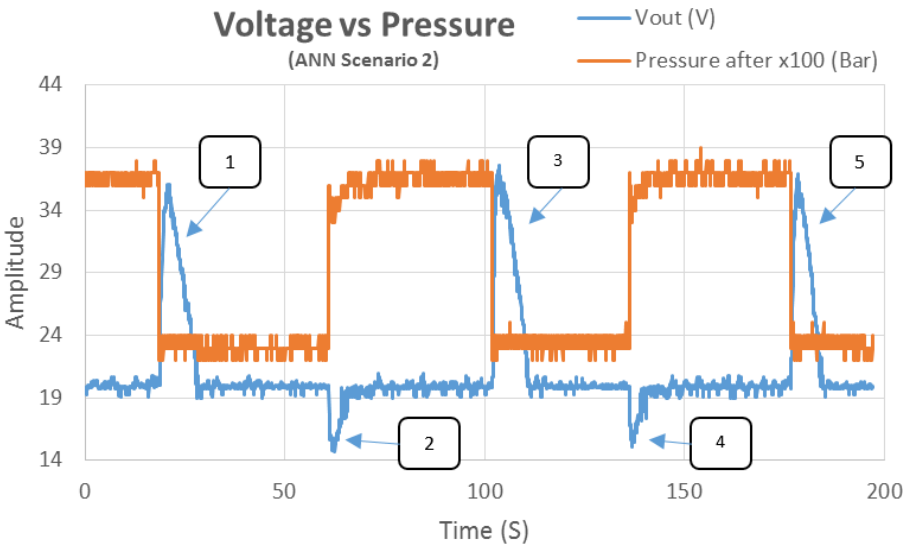
Figure 28. Comparison of voltage and pressure on the ANN scenario.